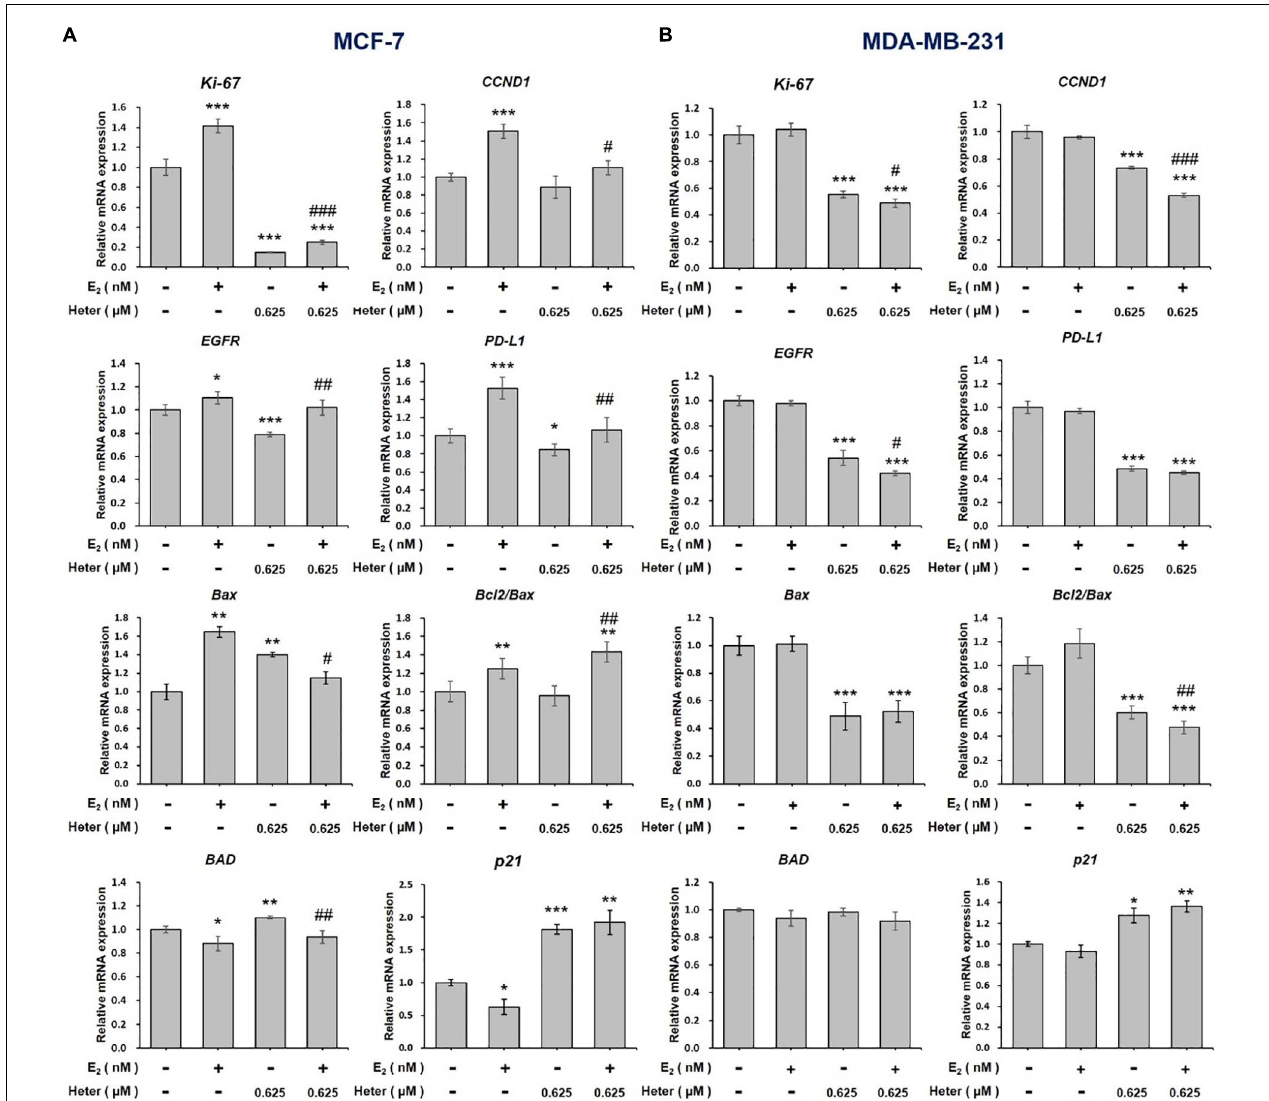
FIGURE 3 | Estrogen and heteronemin regulate expressions of Ki-67, CCND1, EGFR, PD-L1 , B ax , Bcl/Bax , BAD, and p21 in breast cancer cells. (A) MCF-7 and (B) MDA-MB-231 cells were treated with heteronemin (0.625 µ M) in the presence and absence of 1 nM E 2 for 24 h. RNA was extracted and qPCR analyses were conducted for Ki-67, CCND1, EGFR, PD-L1 , Bax , Bcl-2/Bax , BAD, and p21 . The number of independent studies ( n ) = 3. * p < 0.05, ** p < 0.01, *** p < 0.001, compared to the untreated control. # p < 0.05, ## p < 0.01, ### p < 0.001, compared to the same dosage of heteronemin treatment only.